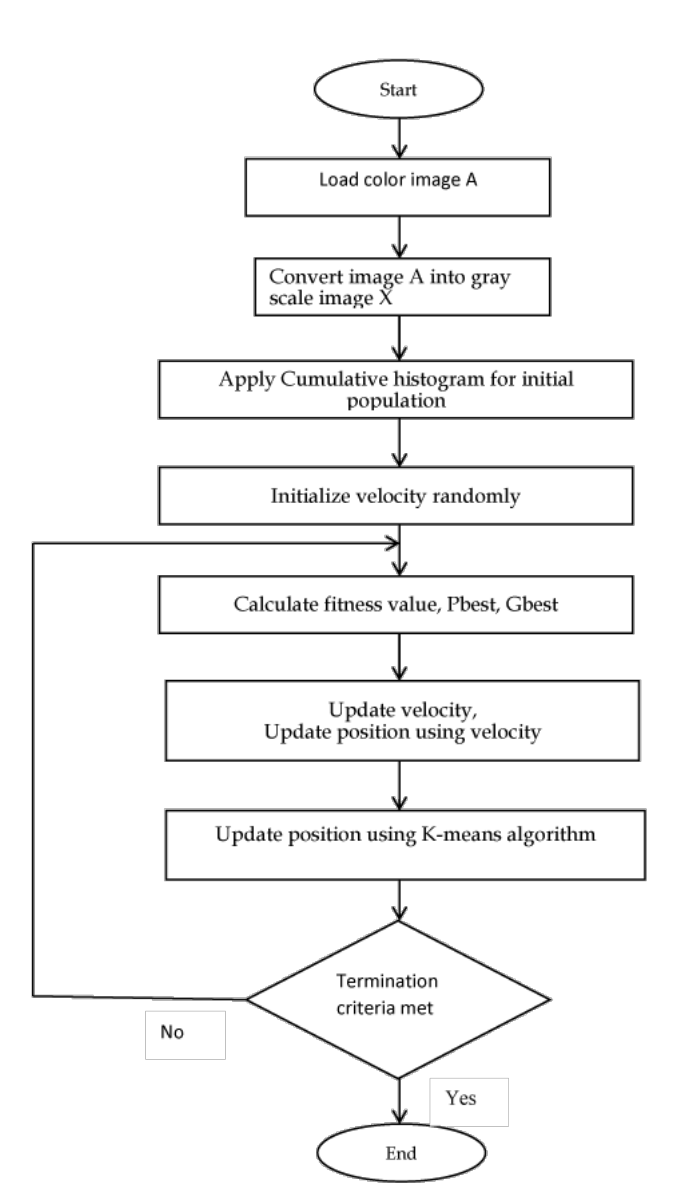
Figure 1. Flow chart of proposed algorithm